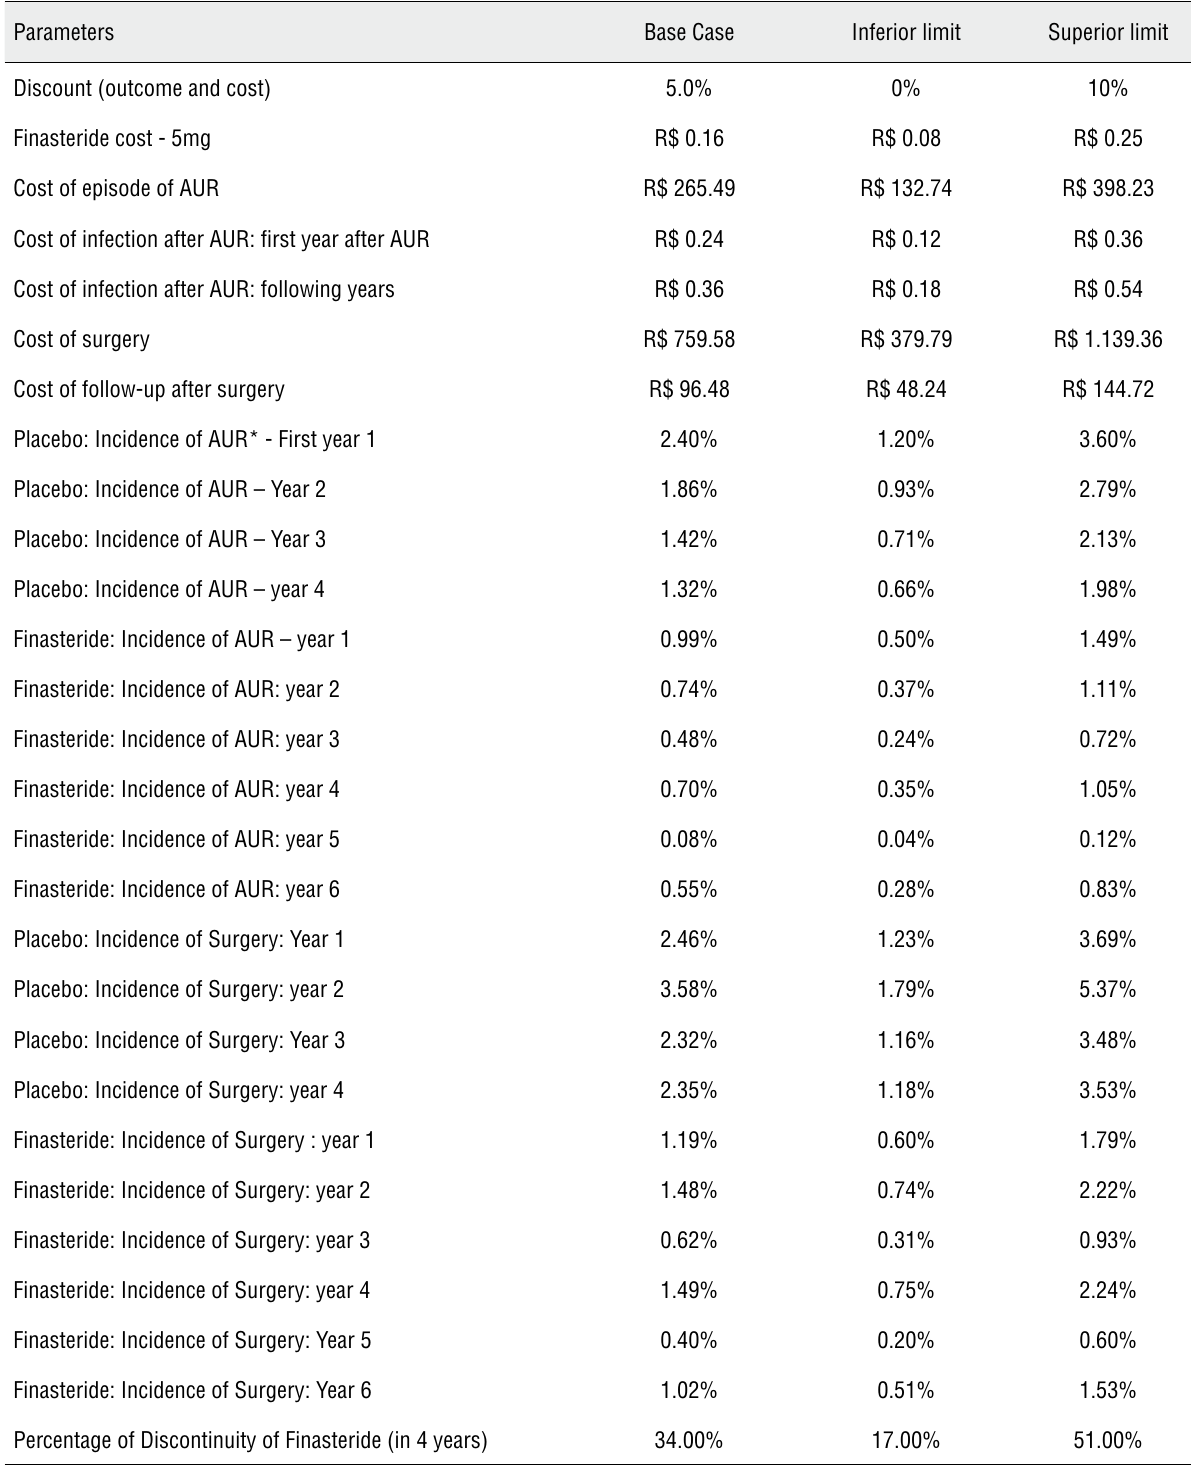
Table 4 - different parameters of sensitivity analysis (finasteride or placebo in a 6 year